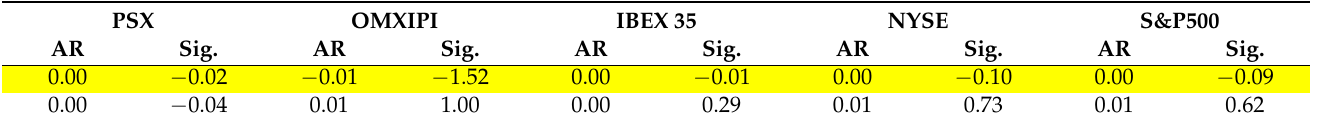
Table A38. Abnormal returns of the (0, +1) event window (Resignation of D. Jos é Manuel Soria, Spain’s Minister of Industry).